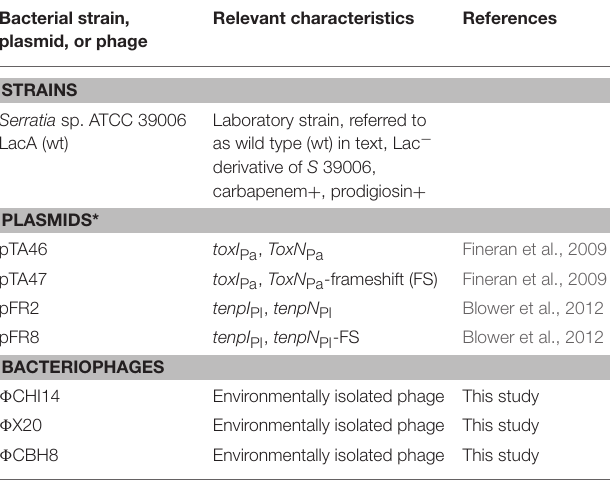
TABLE 1 | Bacterial strains, plasmids, and bacteriophages used in this study. Bacterial strain, plasmid, or